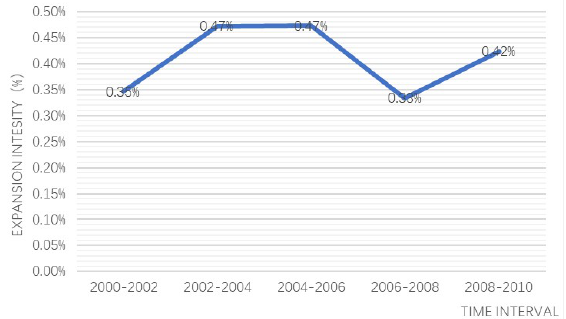
Figure 7 . Expansion intensity of built-up areas in the Yangtze River Delta urban agglomeration.